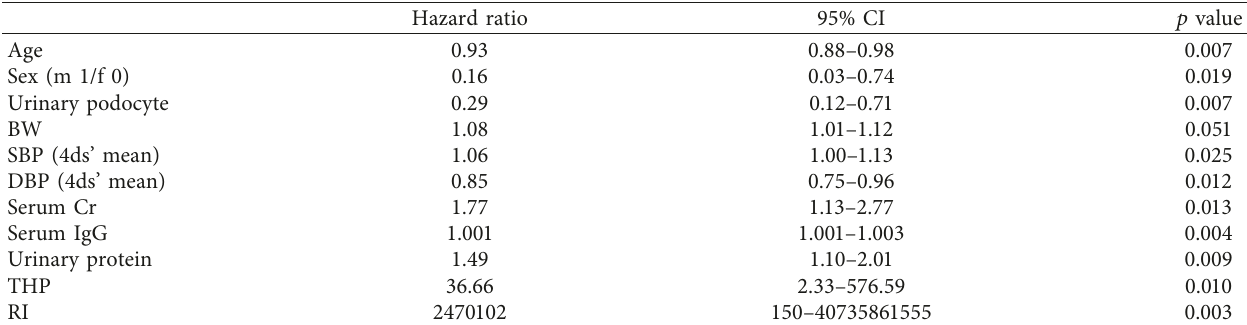
Table 3: Possible risk factors for renal prognosis, including HD or eGFR-30% reduction, by multivariate analysis using a Cox proportional hazards model.